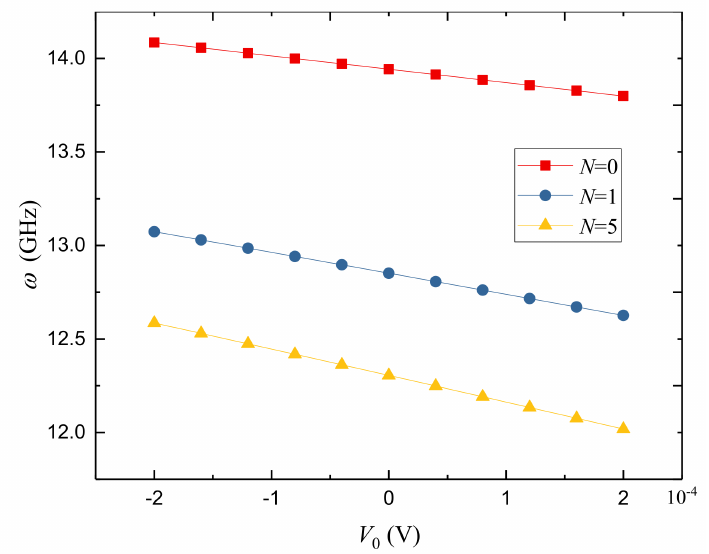
Figure 5. Variation of natural frequency ω (GHz) against external electric potential V 0 for different power-law indexes of FGPM-I nanoshell ( n = 1).